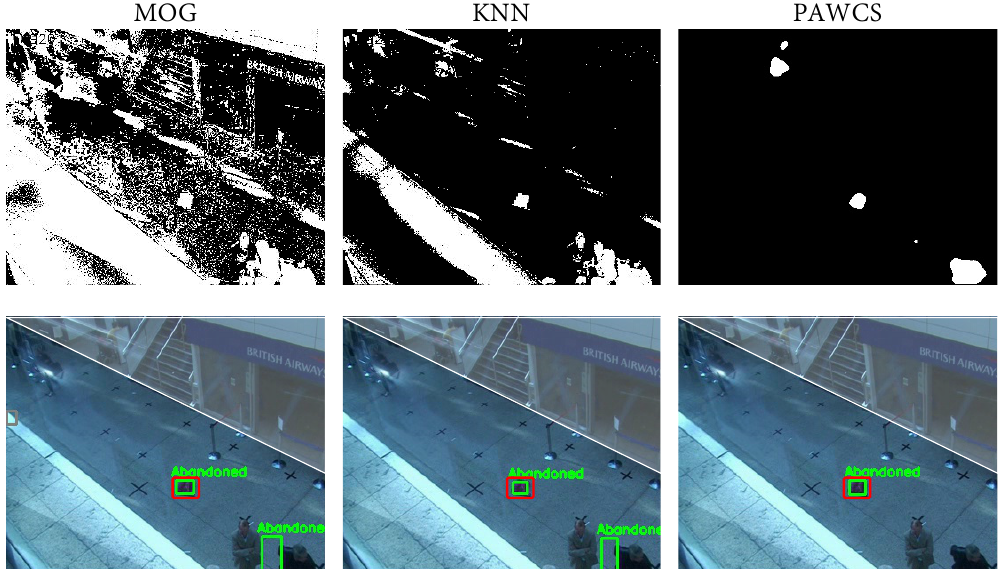
Figure 11. The first row shows the obtained foreground mask of the same frame of sequence PETS07 S7 C3 with the MOG, KNN, and PAWCS algorithm, respectively. The second row shows the correspondent abandoned discrimination. The ground-truth is marked in red; green shows the abandoned detections; and the non-interest region is colored in white. Significant differences between algorithms may be observed regarding the quality of the foreground masks. In this example. MOG and KNN are providing a ghost detection resulting in a false positive detection, which brings precision